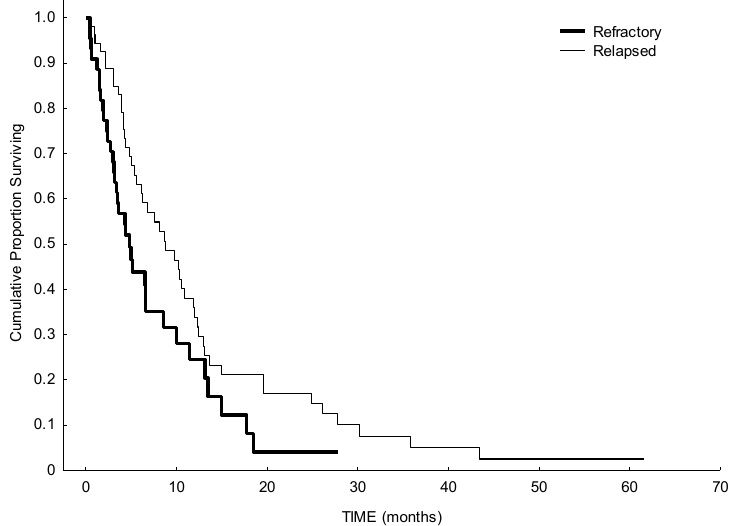
Figure 2. Survival analysis from starting of HMA in refractory versus relapsed AML. Median OS in patients with refractory disease was 4.8 months, while it was higher in patients with relapsed disease (8.8 months) ( p = 0.055).